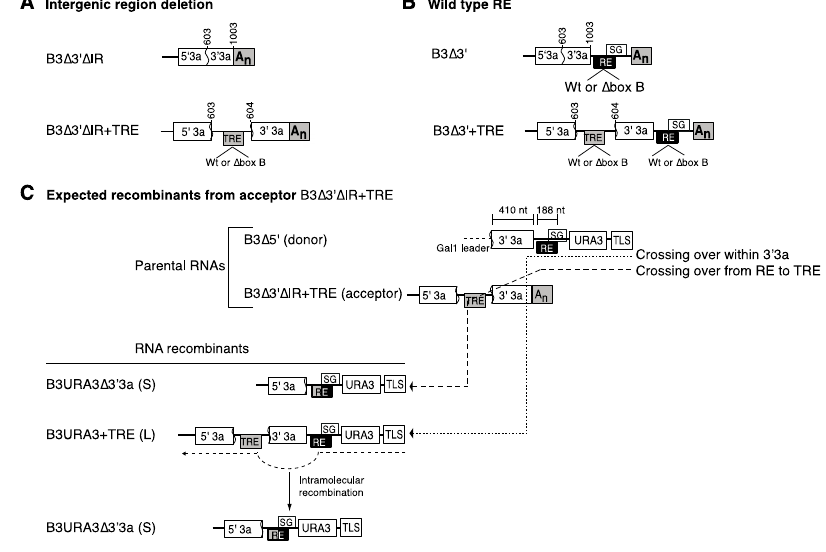
Figure 3. Diagram of parental RNAs and expected recombinants. Non-replicatable B3 ∆ 3 ′ derivatives